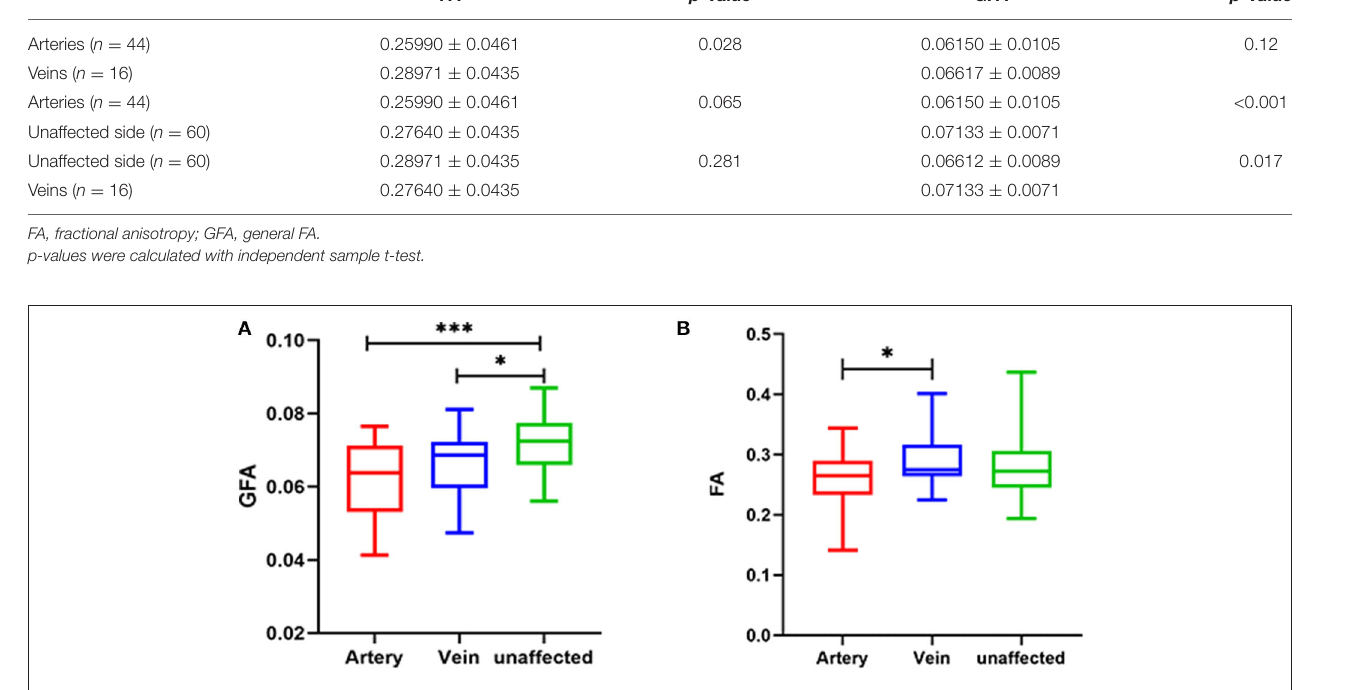
FIGURE 3 | Relationship between responsible vessel types and GFA value (A) and FA value (B) in TN patients (*** p < 0.001; * p < 0.05). GFA, generalized FA; FA, fractional anisotropy; DSI, diffusion spectrum imaging.